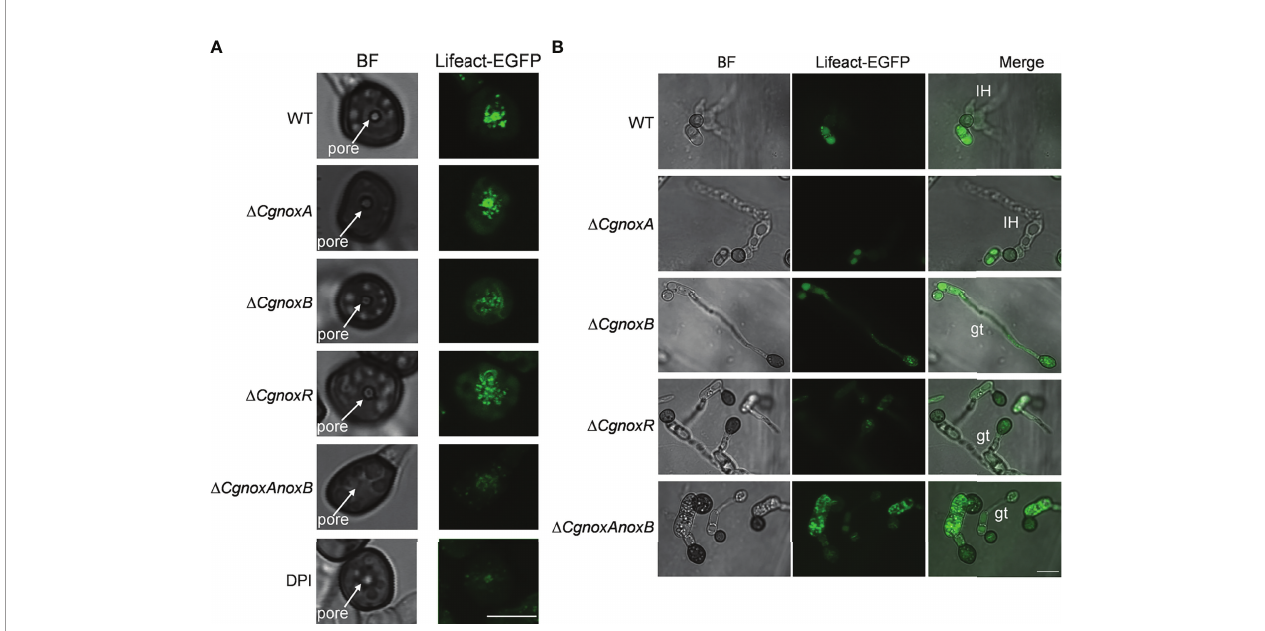
FIGURE 7 | CgNOX regulates F-actin organization during appressorium development and penetration of C. gloeosporioides . (A) Micrographs of F-actin organization in appressorium visualized by expression of Lifeact-EGFP in WT (DPI treatment or not), D CgnoxA , D CgnoxB , D CgnoxR , and D CgnoxAnoxB strains. Conidial suspensions at 2 × 10 5 conidia ml -1 were inoculated onto hydrophobic glass coverslips for 24 h. Scale bar = 5 m m. (B) Micrographs of F-actin organization in appressorium and infectious hyphae of each strain on onion epidermis. Conidial suspensions at 2 × 10 5 conidia ml -1 were inoculated onto onion epidermis for 15 h. IH represents invasive hyphae, gt means germinated tube. Scale bar = 10 m